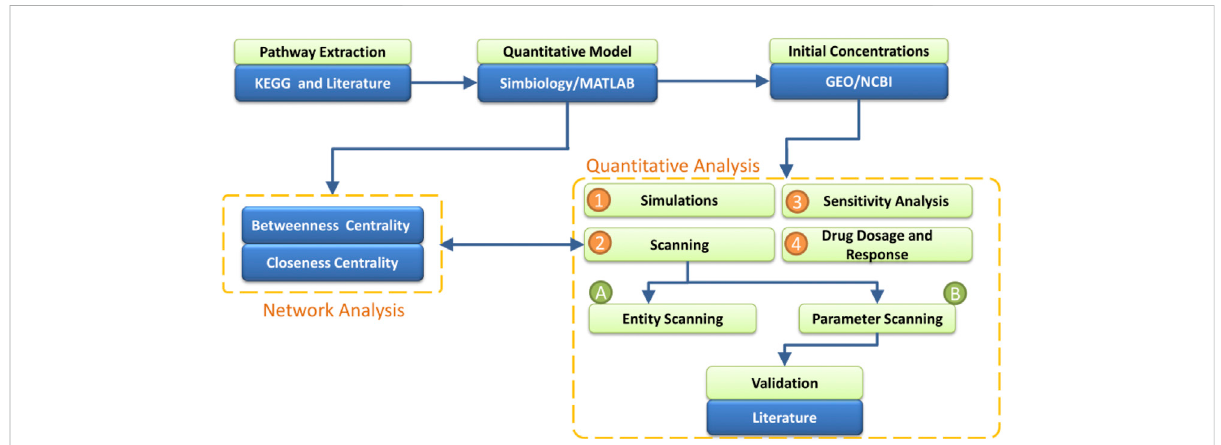
FIGURE 1 Work-Flowofthestudy-TheanalysisstartswiththeextractionofTNF- α mediatedsphingomyelinsignalingpathwayinformationfromliterature and KEGG. The step is followed by the construction of the model of extracted pathways in Simbiology. The model is subjected to two forms of analysis: Network Analysisand Quantitative Analysis. The network analysis includes two measures: Betweenness Centrality and Closeness Centrality which help to identify the essential proteins in the model. For the quantitative analysis, the initial concentrations of entities are incorporated in the model from the microarray gene expression data of normal individuals. The measures of quantitative analysis include Simulation of the model ’ s entities, Scanning of entities and parameters, Sensitivity Analysis of entities vs. entities and parameters vs. entities, and the effect of different Drugs ’ Dosages (Etanercept, Nivocasan, and Scyphostatin) over the model. Moreover, the results from Network Analysis and Quantitative Analysis are